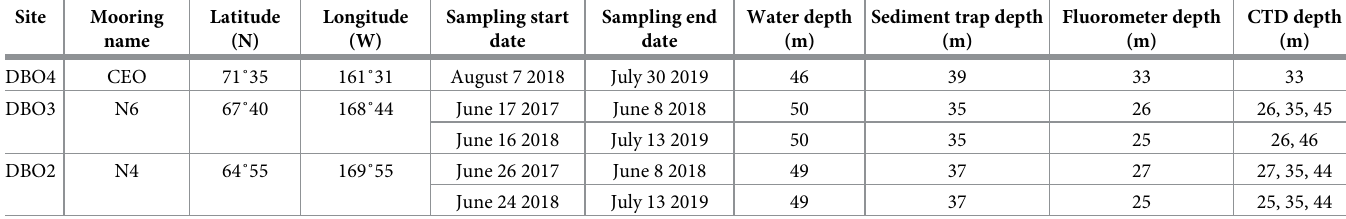
Table 1. Mooring and sediment trap deployment information.